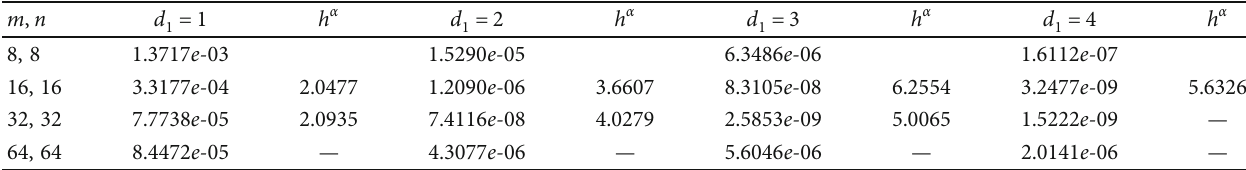
= 7 at t = 1 for Chebyshev nodes. 2